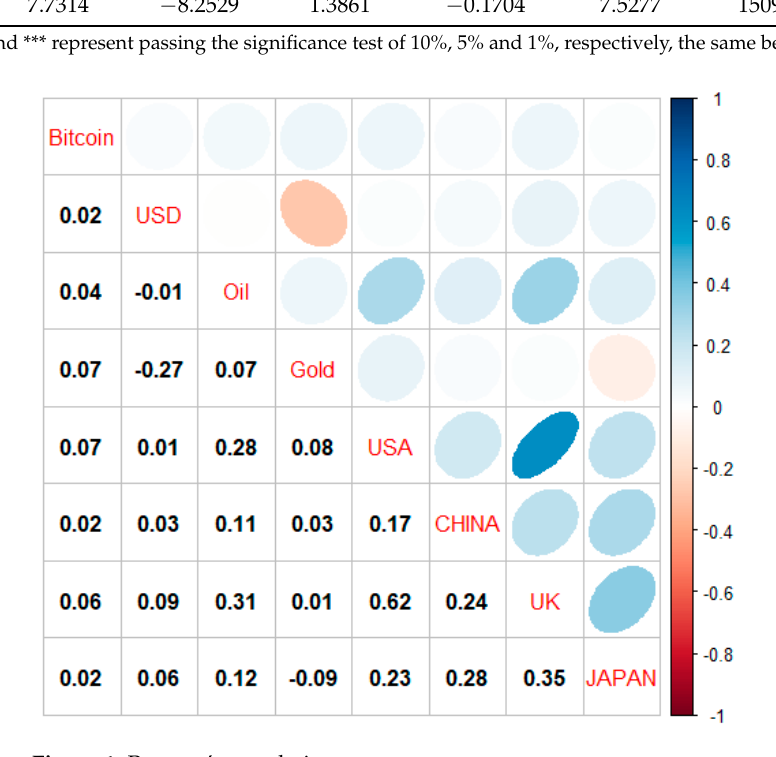
Figure 1. Pearson’s